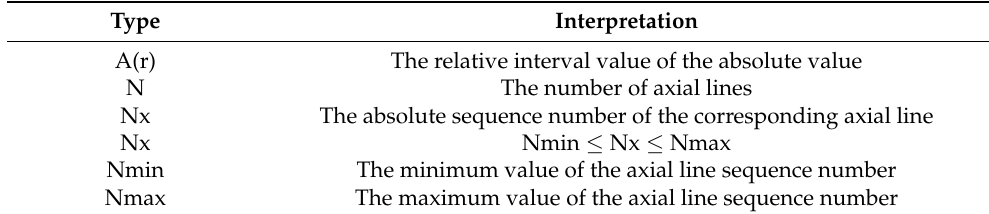
Table 3. Relative value calculation formula